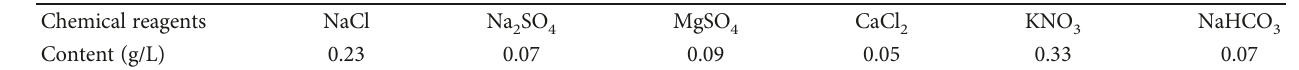
Table 1: Chemical reagent usage.